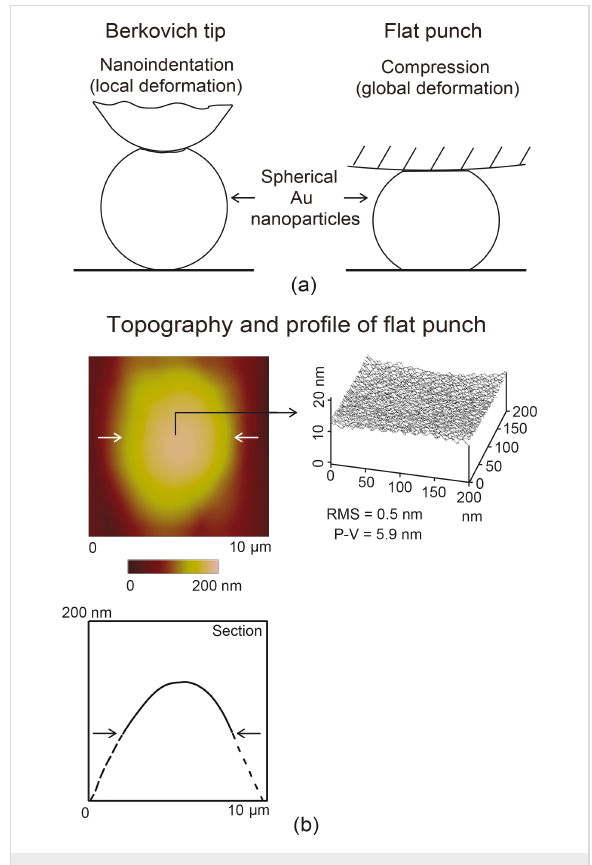
Figure 6: (a) Schematic showing method of deformation by using a Berkovich tip for nanoindentation (local deformation) and flat punch for compression (global deformation) with Au nanoparticles. (b)Topog- raphy map (top) and 2-D profile (bottom) of flat punch at the section shown by the pairs of horizontal arrows along with a typical line plot (right) of a 200 nm × 200 nm section indicated by the single horizontal